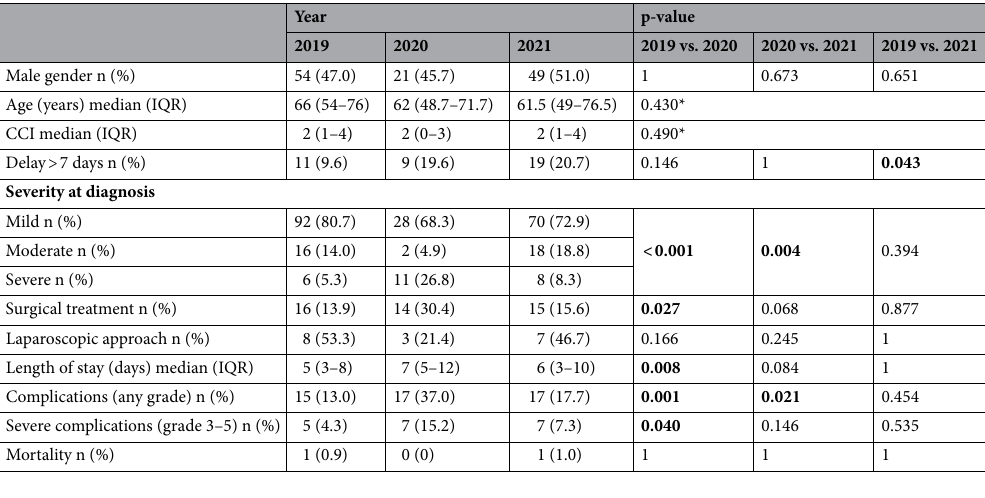
Table 4. Diverticulitis patients characteristics. CCI Charlson Comorbidity Index. *Non-significant p-value in Kruskal–Wallis test, therefore no multiple comparations were performed.